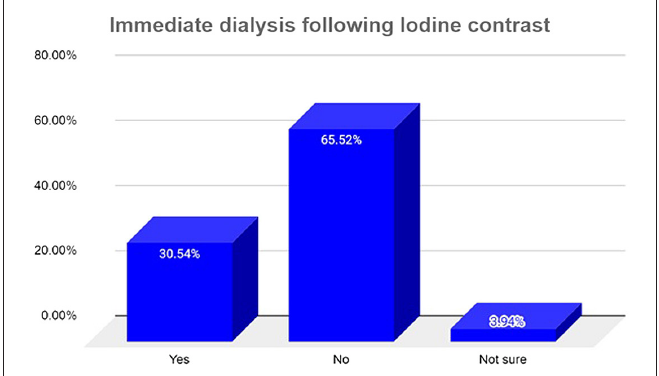
Figure 4. Immediate dialysis following iodine